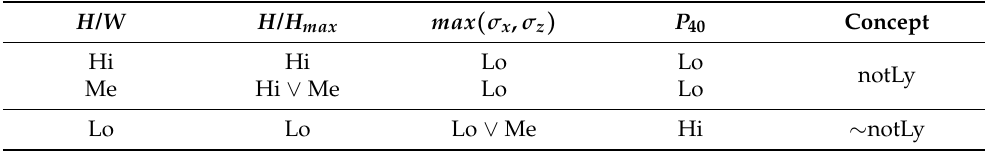
Table 4. Specification of the most relevant attribute values for decision classes, where Lo, Me and Hi means low, average and high value of the feature, respectively and Ly means lying